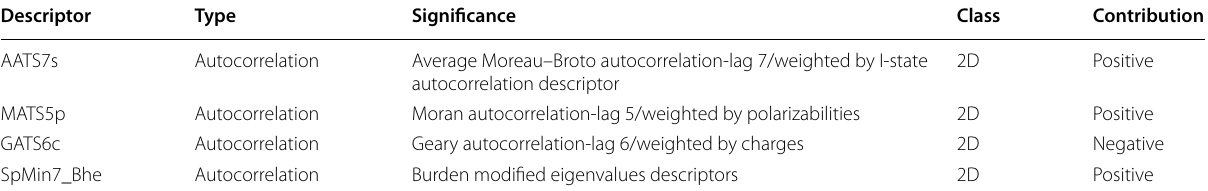
Table 2 Descriptors used in the model